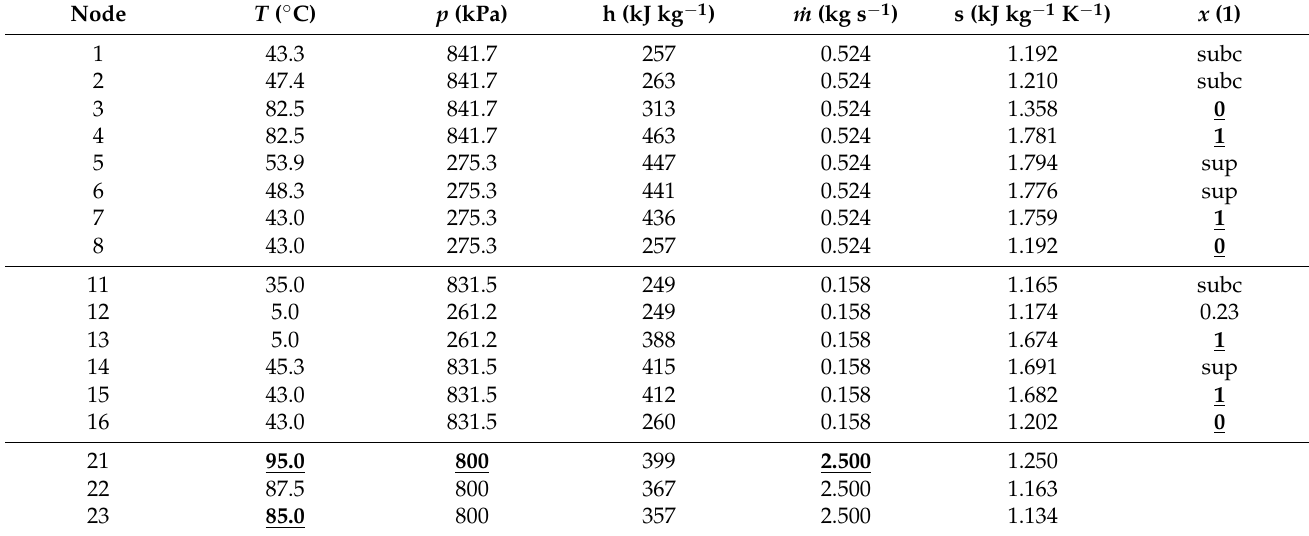
Table A2. Parameters of the ORC-VCC in its nodes for baseline conditions (imposed values in underscored